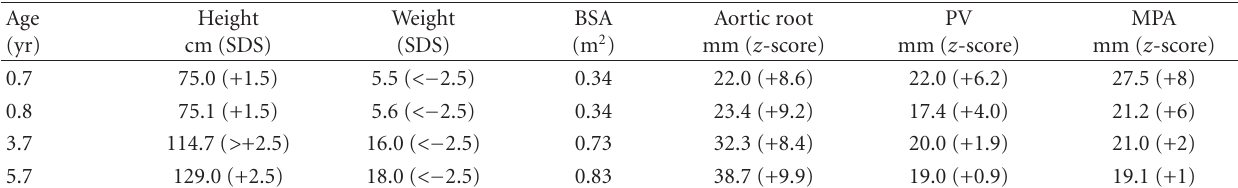
Table 1: Aortic root diameters and pulmonary artery diameters during